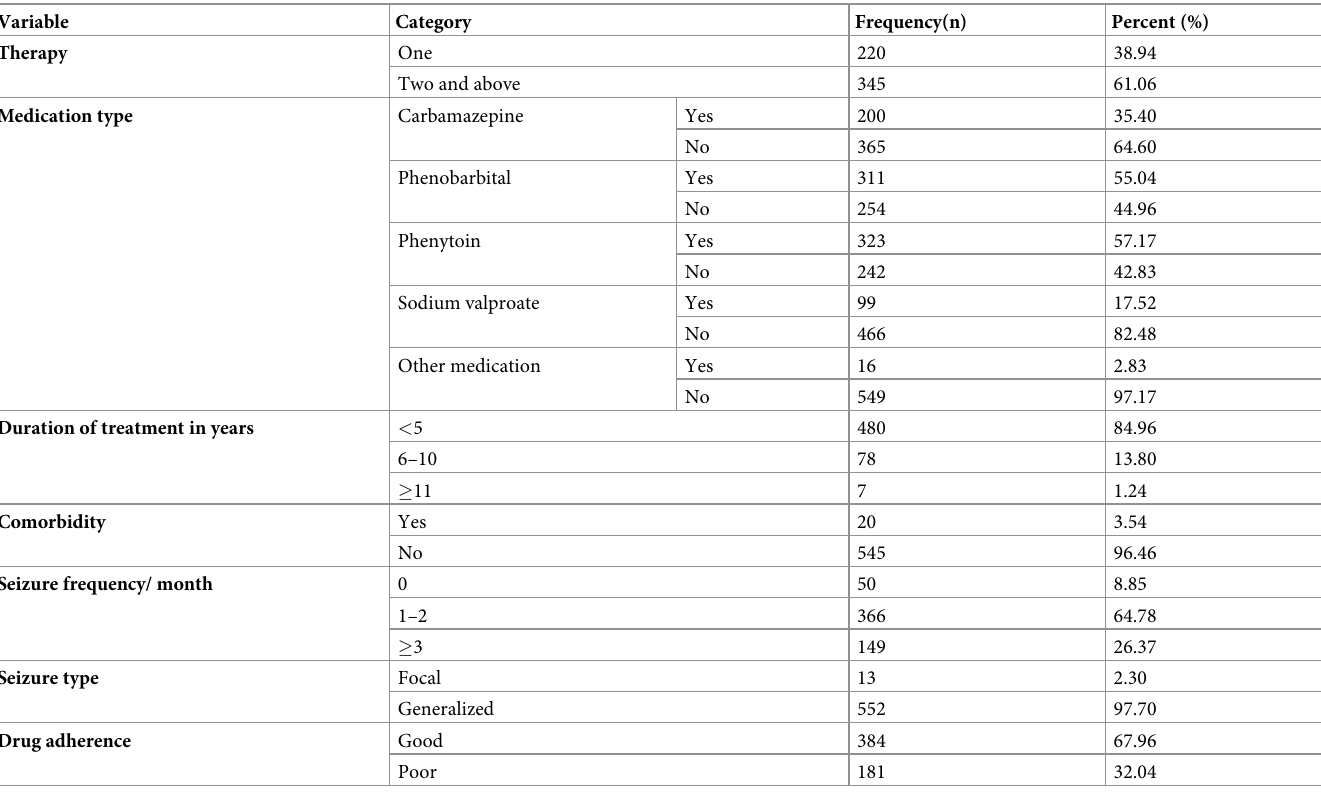
Table 2. Clinical characteristics of adult patients with epilepsy attending follow-up care at referral hospitals in Amhara region, Ethiopia, 2021 (n = 565). Variable